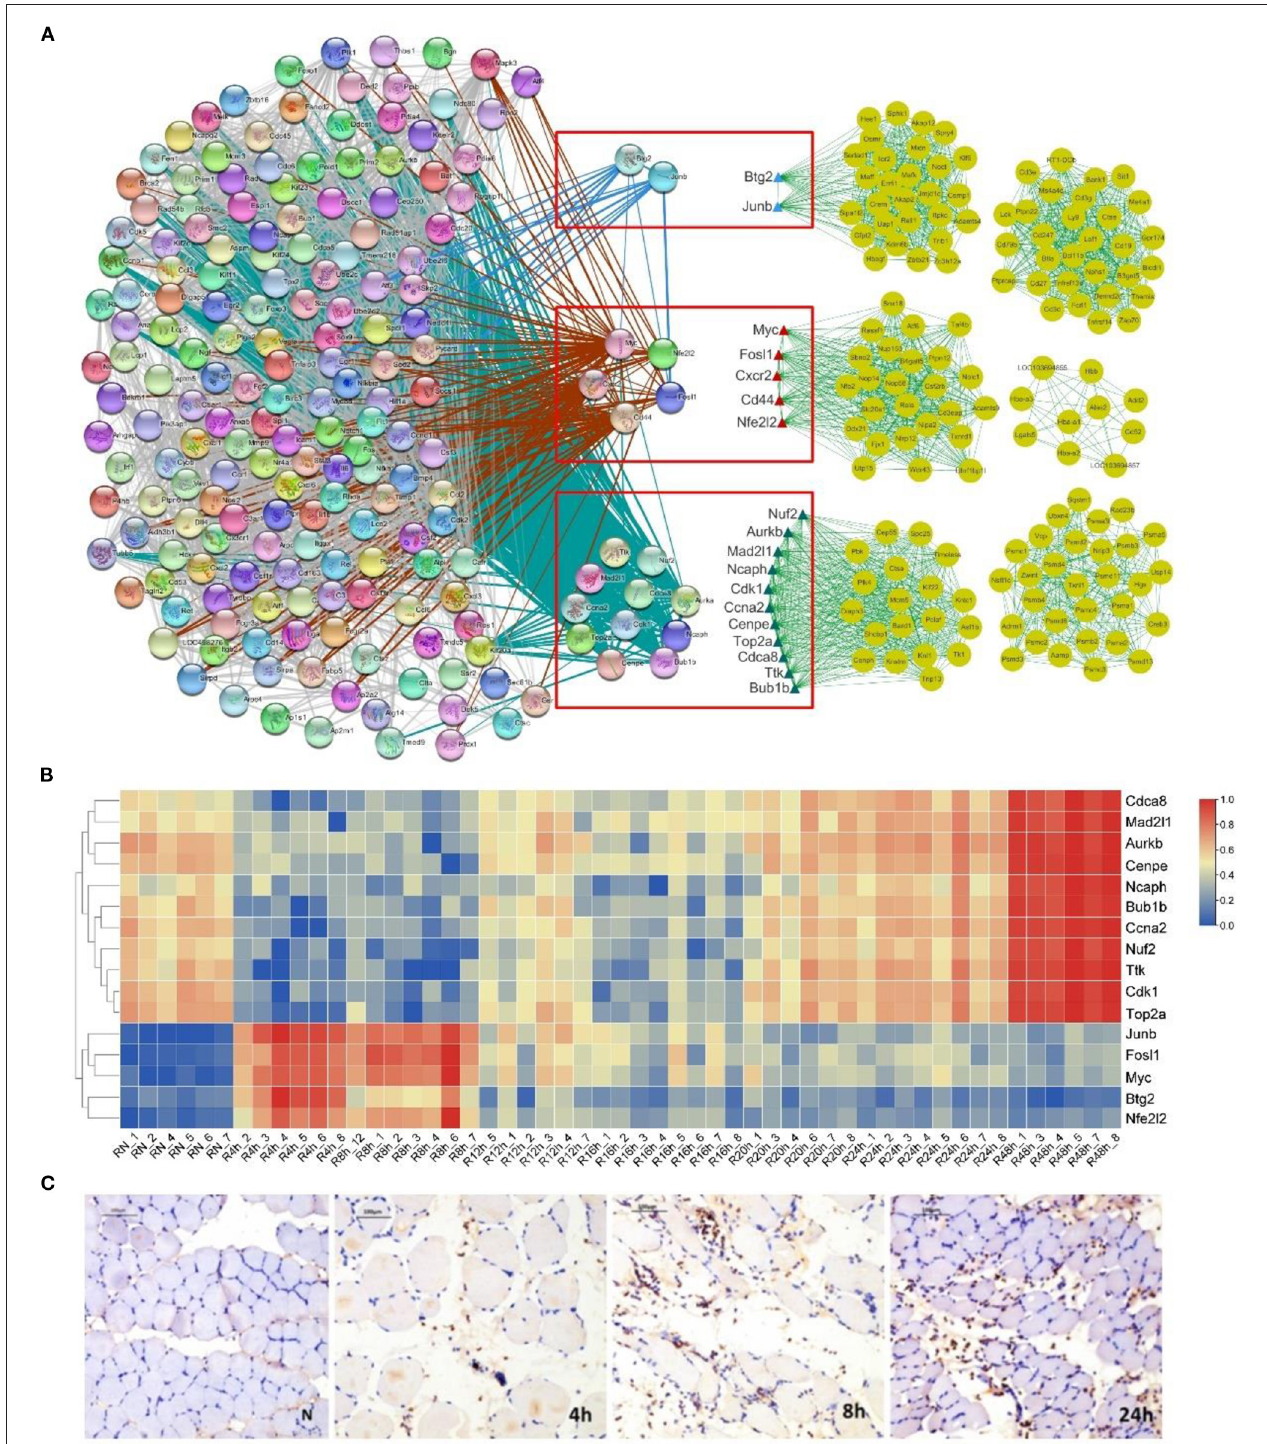
FIGURE 5 | Gene net and heat map of 18 selected gene markers and distribution of neutrophils during the early period after SMI. (A) Net of 18 marker genes (red-outlined boxes) selected by the intersecting the 188 time-dependent gene set and 161 hub genes distributed across the six HCr modules identified using WGCNA. The gene network on the left represents the 188 time-dependent genes. The six gene networks on the right represent hub genes selected by WGCNA. The blue, red, and green triangles represent different modules. (B) Heat map of 18 marker genes representing their time-dependent expression. (C) Immunohistochemical staining for the neutrophil marker MPO. Representative images of transverse sections from three experimental groups and the control group are shown. MPO-positive neutrophils are indicated by brown particles. Scale bar: 100 µ m.